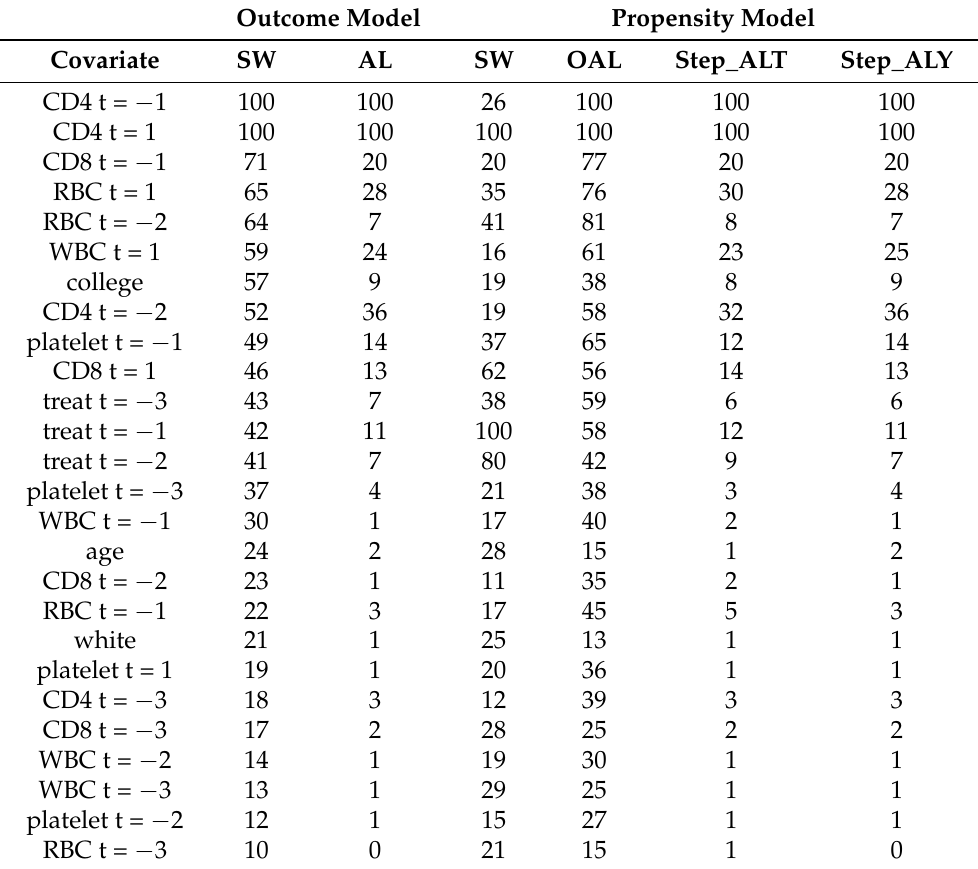
Table A5. Proportion of each variable selected for prediction model across 1000 bootstrap